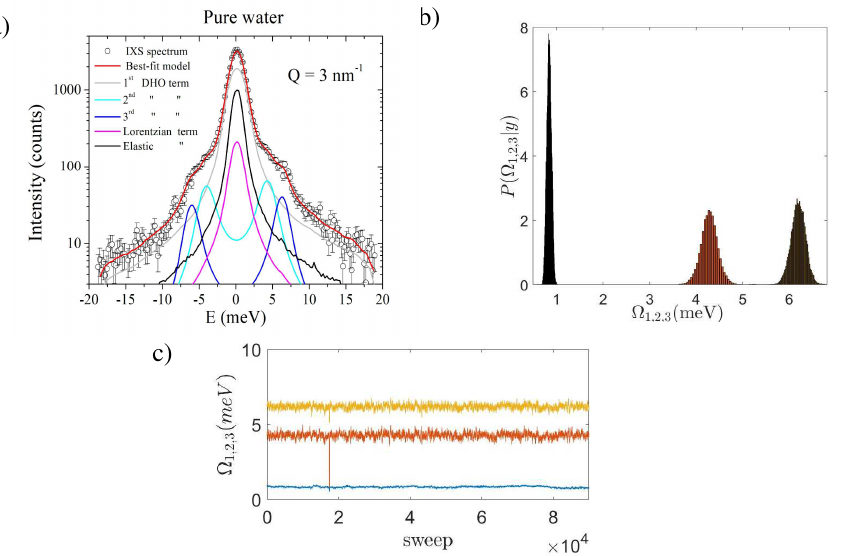
Figure 4. ( a ) the IXS spectrum of pure water measured at Q = 3 nm − 1 is compared with the best-fit lineshape and its individual components (see Equation (1)); ( b ) posterior distributions associated with the dominant energies Ω 1 , Ω 2 and Ω 3 of the three DHO profiles; ( c ) the variation of the parameter value as a function of the algorithm’s